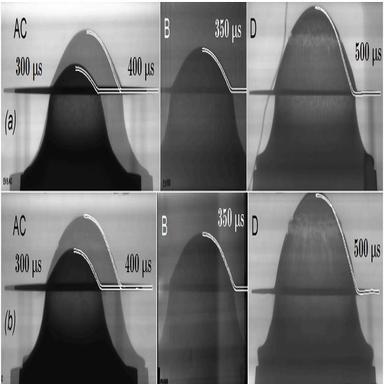
Experimental flash X-ray results and comparison with the calculations (shown as half plate white contours) for the moisturised fine silica sand loaded by the configuration U charge, ρ0 = 1.59 g/cm3 (a) and configuration V charge, ρ0 = 1.58 g/cm3 (b).